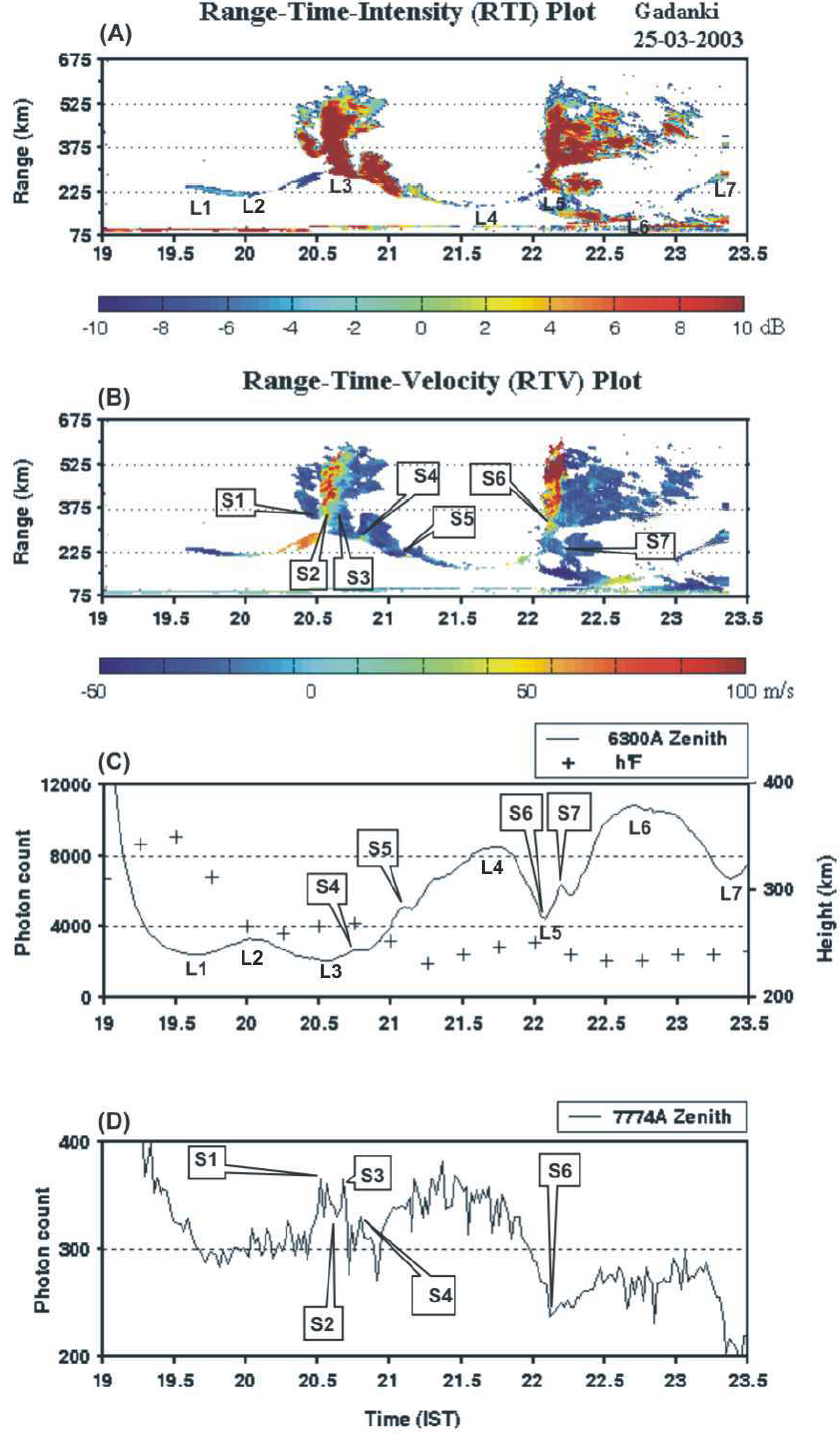
Fig. 1. Composite plots of temporal variations of ( A ) Range and Intensity (RTI), ( B ) Range and Velocity (RTV), ( C ) 630.0-nm airglow intensity (solid line) along with h’F ( +) and ( D ) 777.4 nm airglow intensity on an equatorial Spread F night, 25 March 2003. The colour codes in (A) and (B) denote the intensity and the velocity respectively. L1 to L7 represent the nodal points of the macro variations in airglow intensity corresponding to the bottomside structures revealed by RTI map. S1 to S7 represent the region of mutual correspondence between the radar structures and the micro variations in the airglow intensity. Note that the variations denoted by S1 to S3 are only in 777.4-nm while the variation denoted by S7 is only in 630.0-nm. However, the variarions denoted by S4 to S6 are found in both the emission